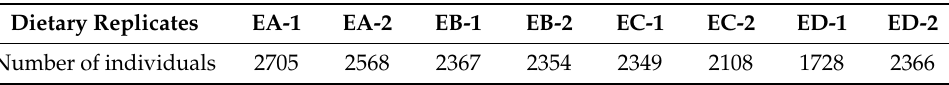
Table 1. Number of individuals in each replicate tank (EA-1, EA-2, EB-1, EB-2, EC-1, EC-2, ED-1, ED-2) at 15 days after hatching. Different numbers (with the same prefix) refer to each replicate from the same enrichment product. Dietary